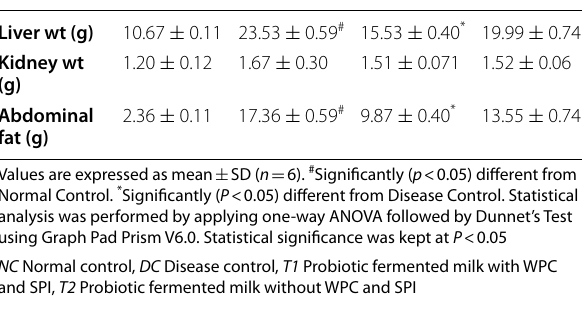
Table 2 Effect of probiotic treatment on organ weights after 10 weeks in high fat diet induced obesity